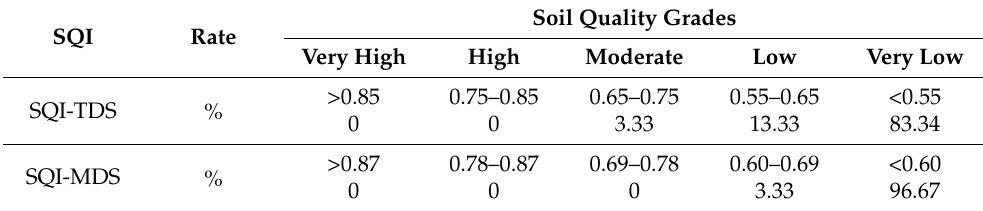
Table 5. Classification and proportion of soil quality grades using different analysis